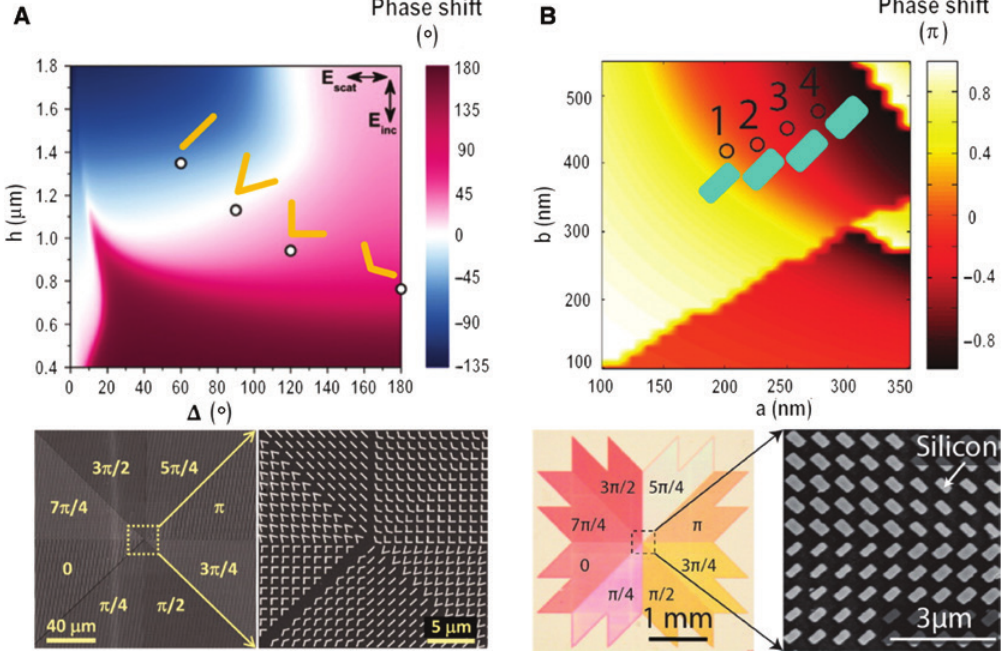
Figure 4: Geometric phase enables a full phase control of nanoattenas to generate optical vortex. (A) Phase ramp of a set of four V-shaped nanoattenas covers from 0 to π , by rotating the element with π /2, additional phase with π arising from the geometric phase enables the optical vortex generation after pattering along the azimuthal direction. Reprinted from Ref. [90]. (B) A hybrid dielectric metasurface composed of silicon nanorods enables high conversion efficiency in a broad spectral range. Reprinted from Ref.